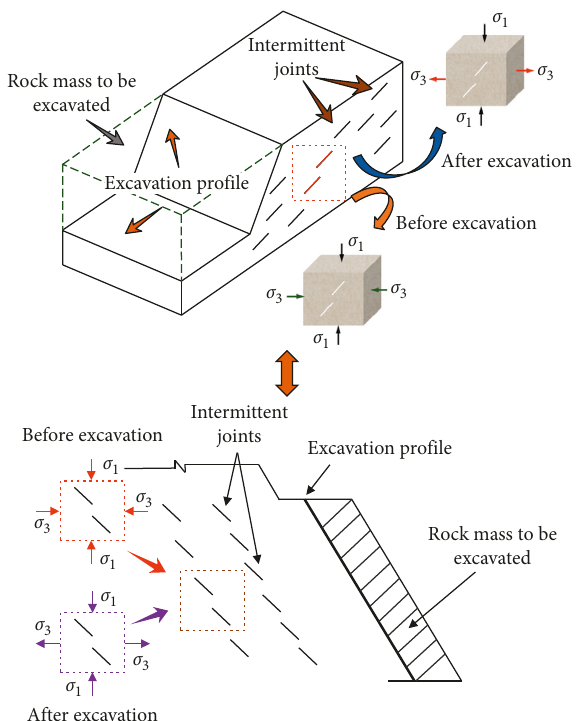
Figure 2: Sketch of mechanical models of “key block” in slope before and after